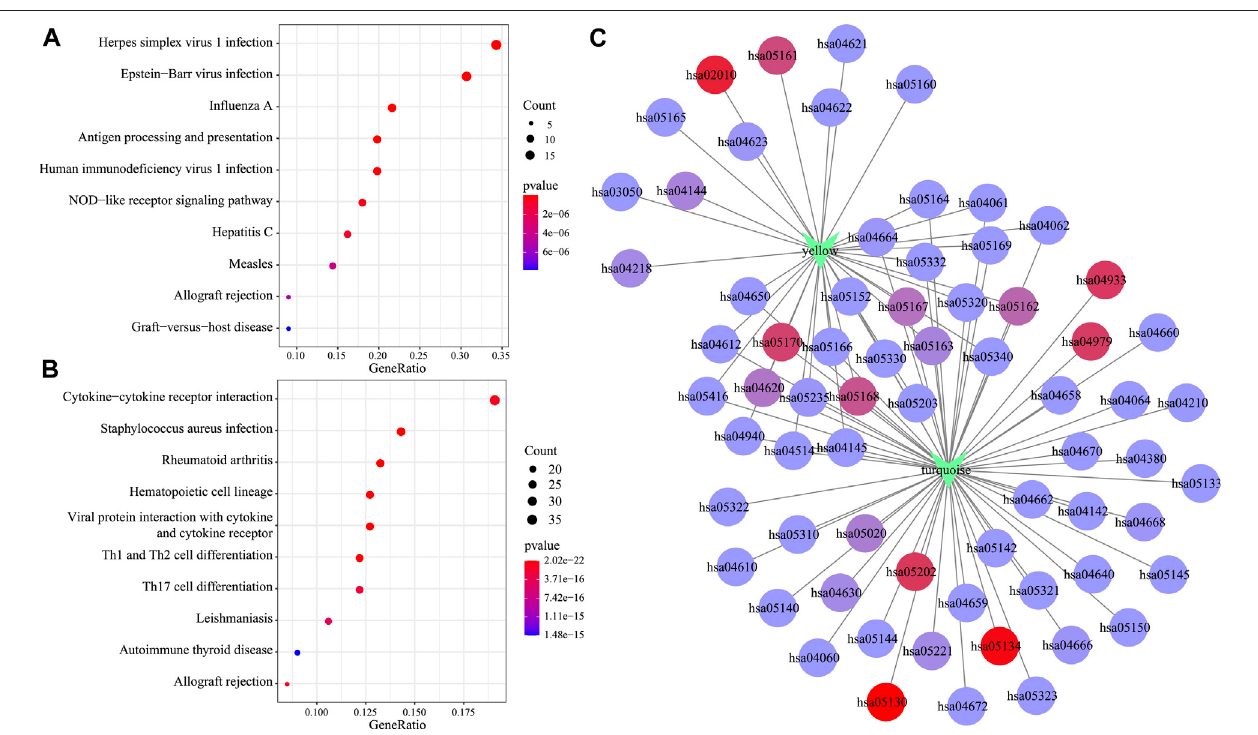
FIGURE 8 | Functional analysis of gene modules signi fi cantly related to subtypes C2. KEGG enrichment analysis results of genes in the yellow module (A) and the turquoise module (B) . Intersection network of enrichment pathways between the two modules (C) .